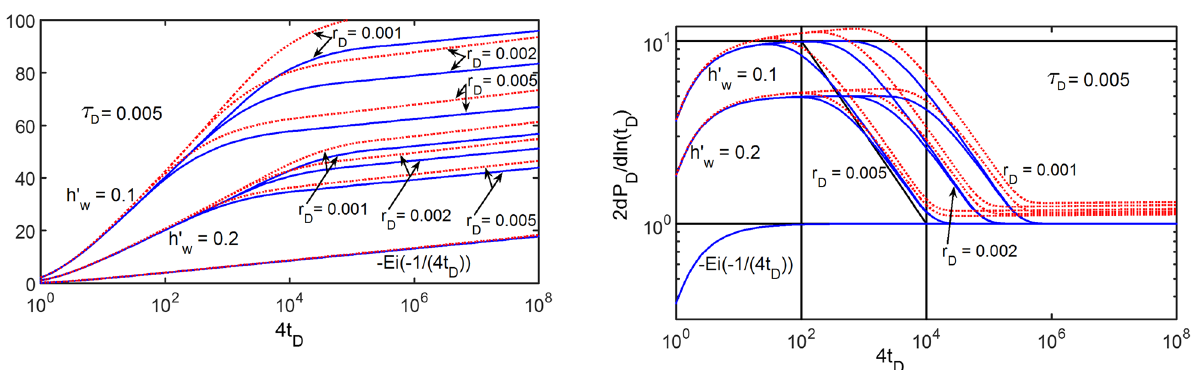
Fig. 3 Comparison of dimensionless pressure, with and without stress